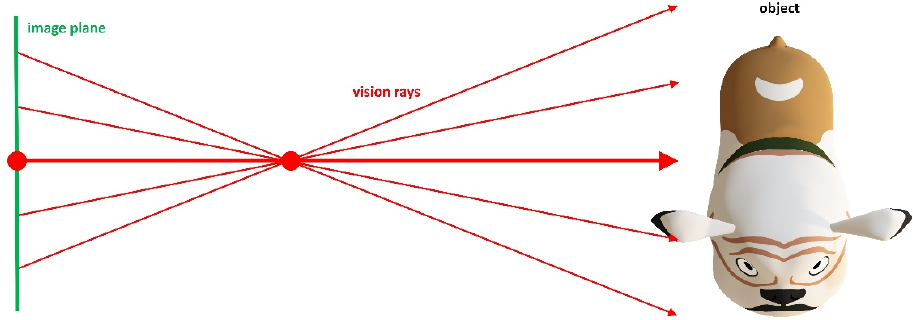
Figure 1. Pinhole ‐ camera model. All rays intersect in a single viewpoint. Figure 1. Pinhole-camera model. All rays intersect in a single